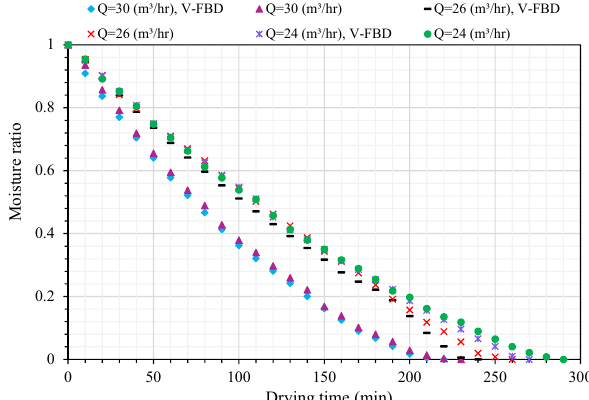
Fig. 4. Moisture ratio versus drying time of hawthorn at different drying air flow rates (drying air temperature=50 o C and vibration intensity=7.5 Hz in vibro mode)